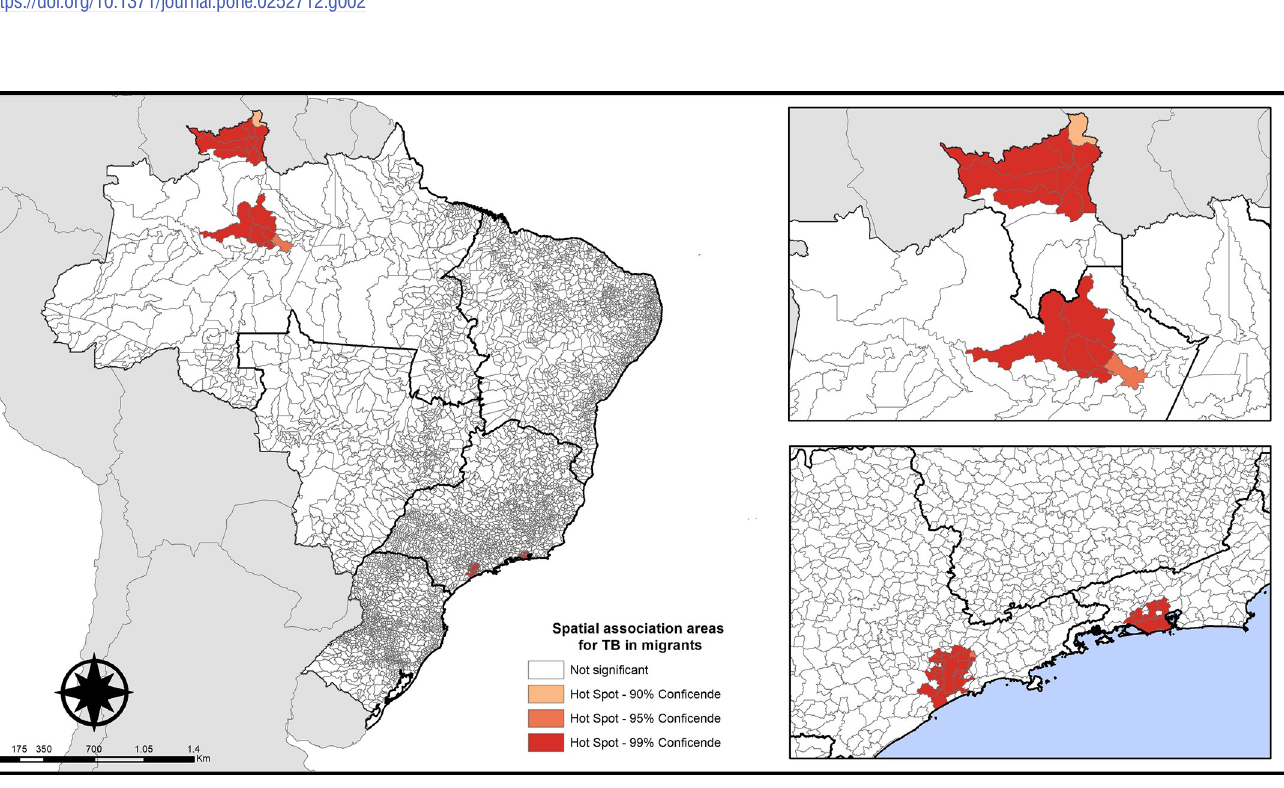
PLOS ONE | https://doi.org/10.1371/journal.pone.0252712 June 9, 2021 7 /